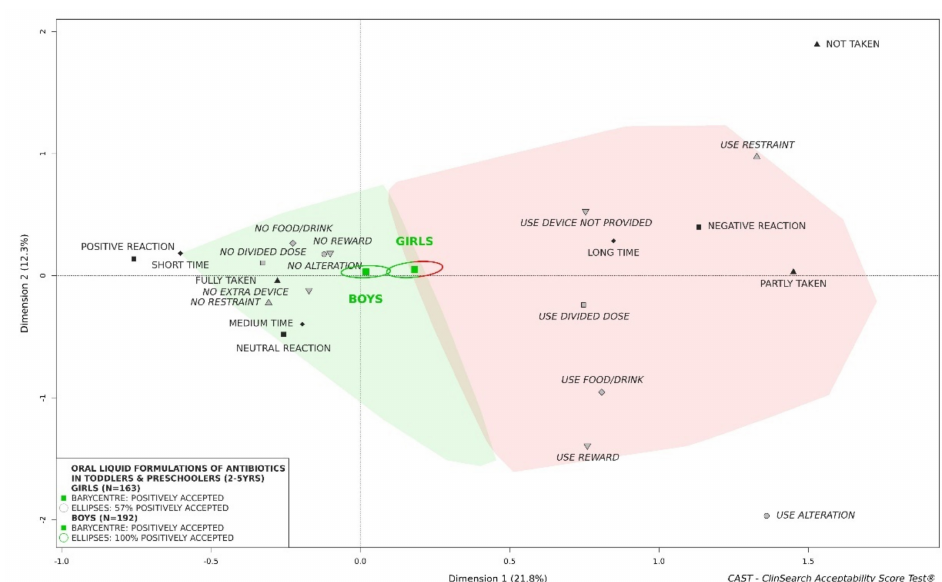
Figure 7. Acceptability of oral liquid formulations of antibiotics in toddlers and preschoolers depend- ing on sex of patients.